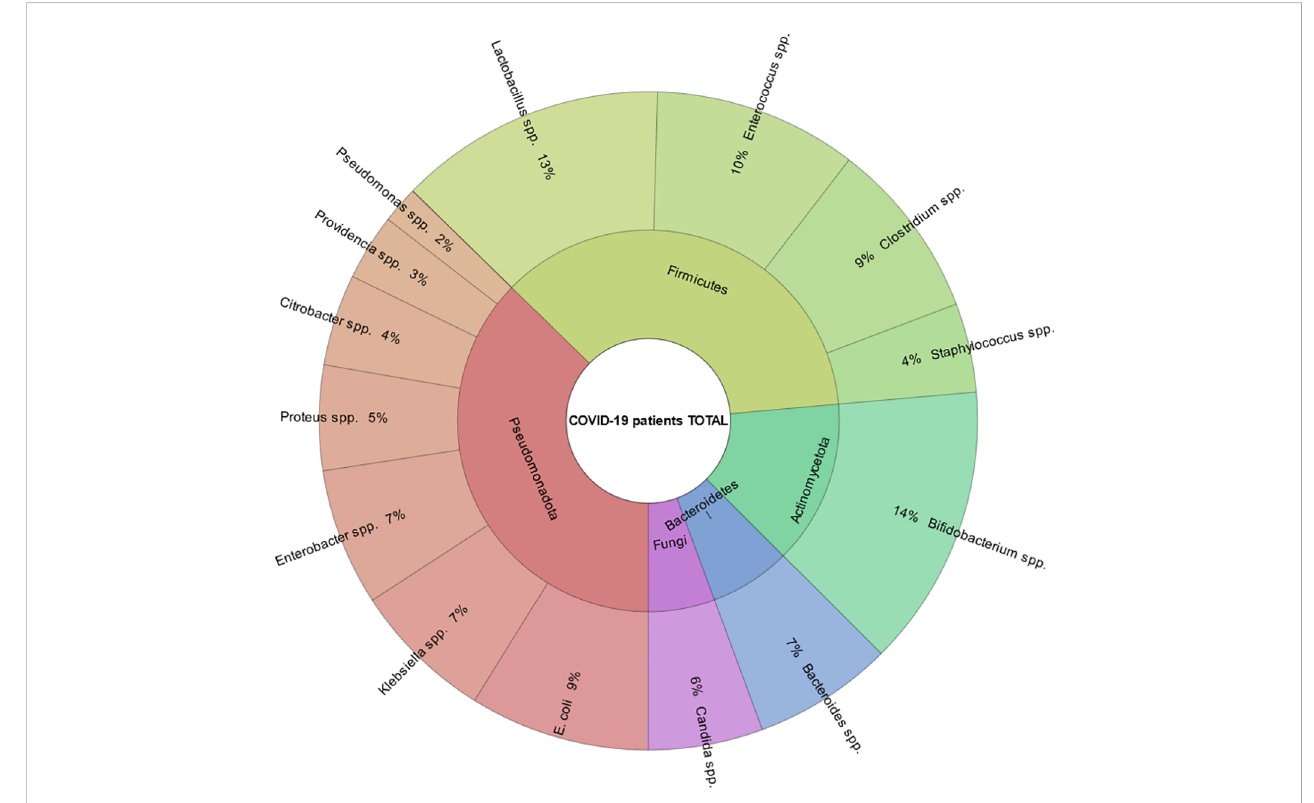
FIGURE 4 Median percentage of gut bacteria in all patients included in the